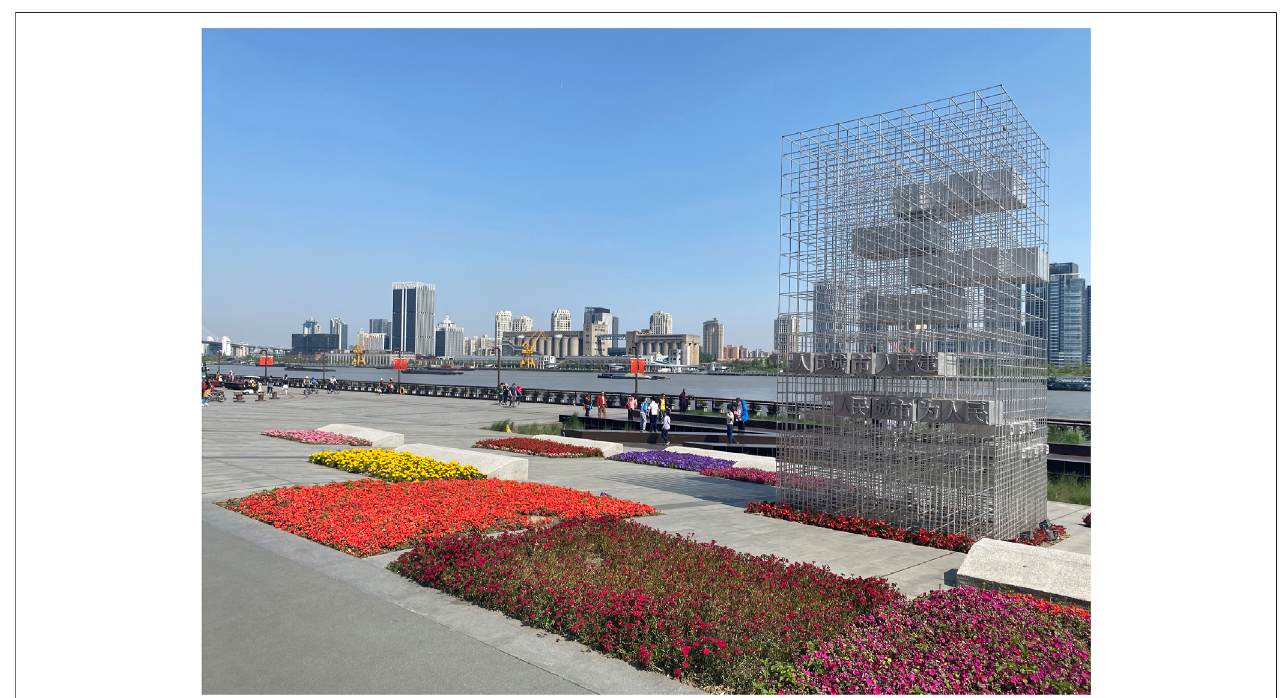
FIGURE 4 | People oriented “ Eco for charming ” along the Huangpu River in Yangpu District (Photo by author, May 2021.